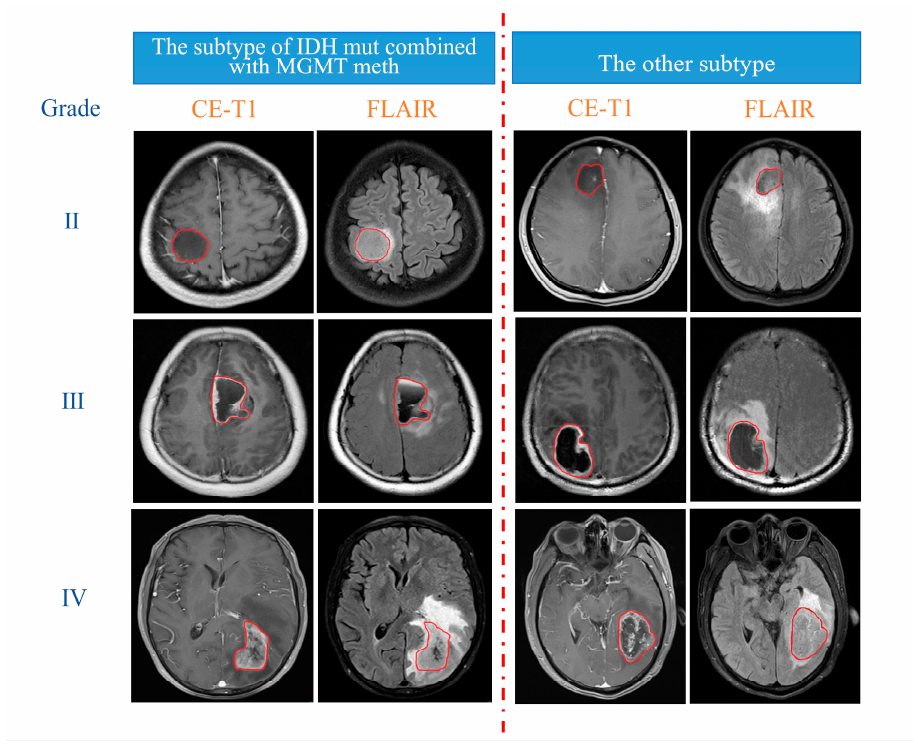
Figure 2. Delineation details of the ROI in irregular red circles.